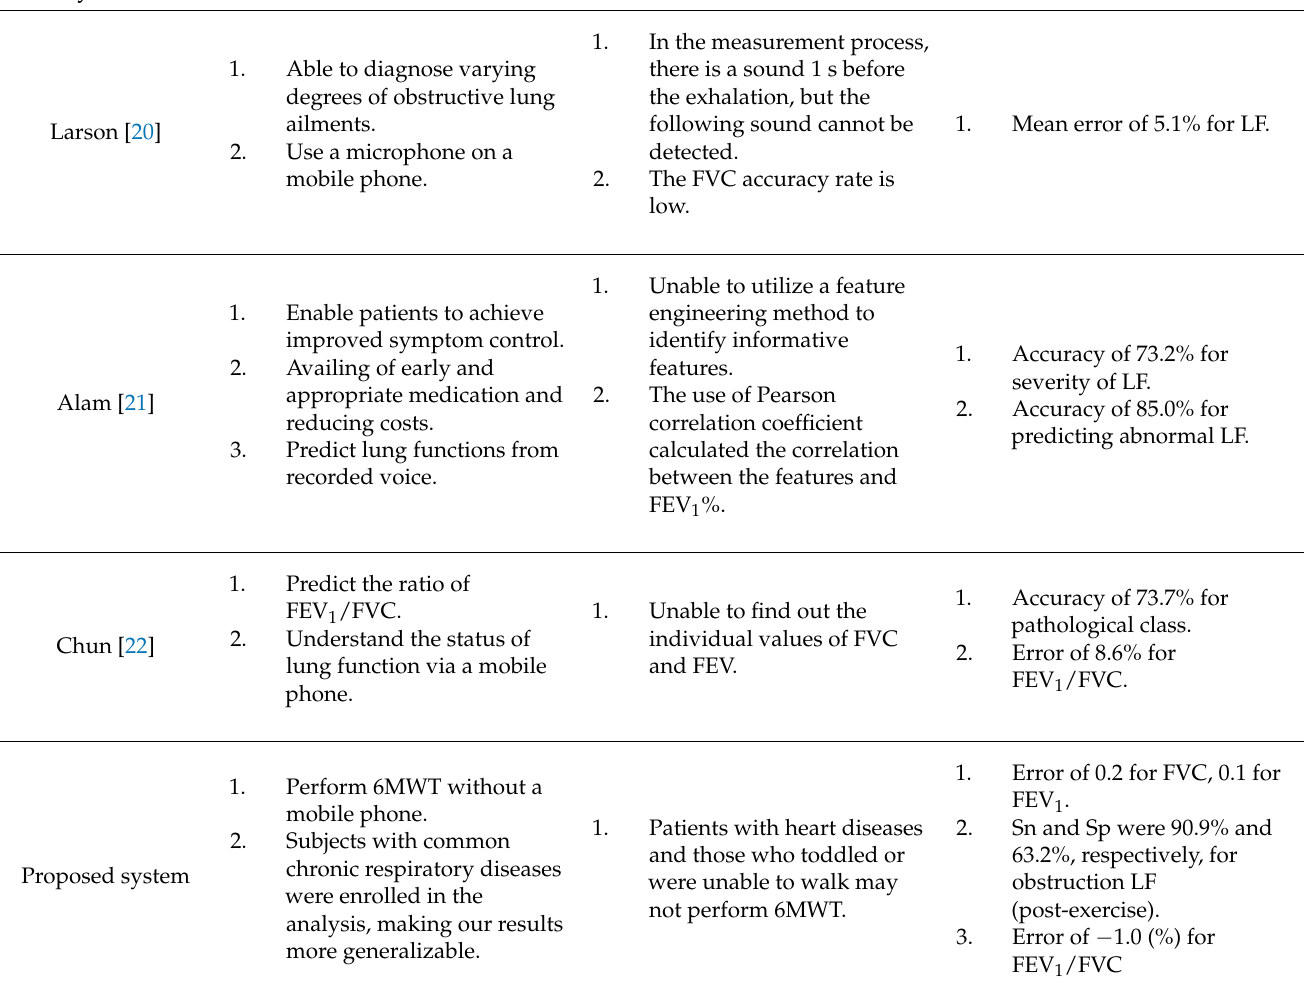
Table 4. Comparison of portable devices for lung